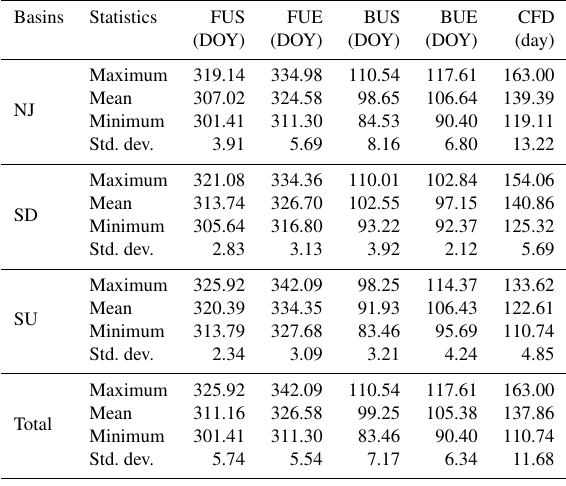
Table 1. Summary of statistics of ice phenology interpolated by the kriging method from 2010 to 2015. The ice phenology indicators in- cluded freeze-up start (FUS), freeze-up end, break-up start (BUS), break-up end (BUE), and complete frozen duration (CFD). NJ, SD, and SU represent the Nenjiang Basin, the downstream Songhua River Basin, and the upstream Songhua River Basin. DOY denotes day of year. Std. dev. denotes standard